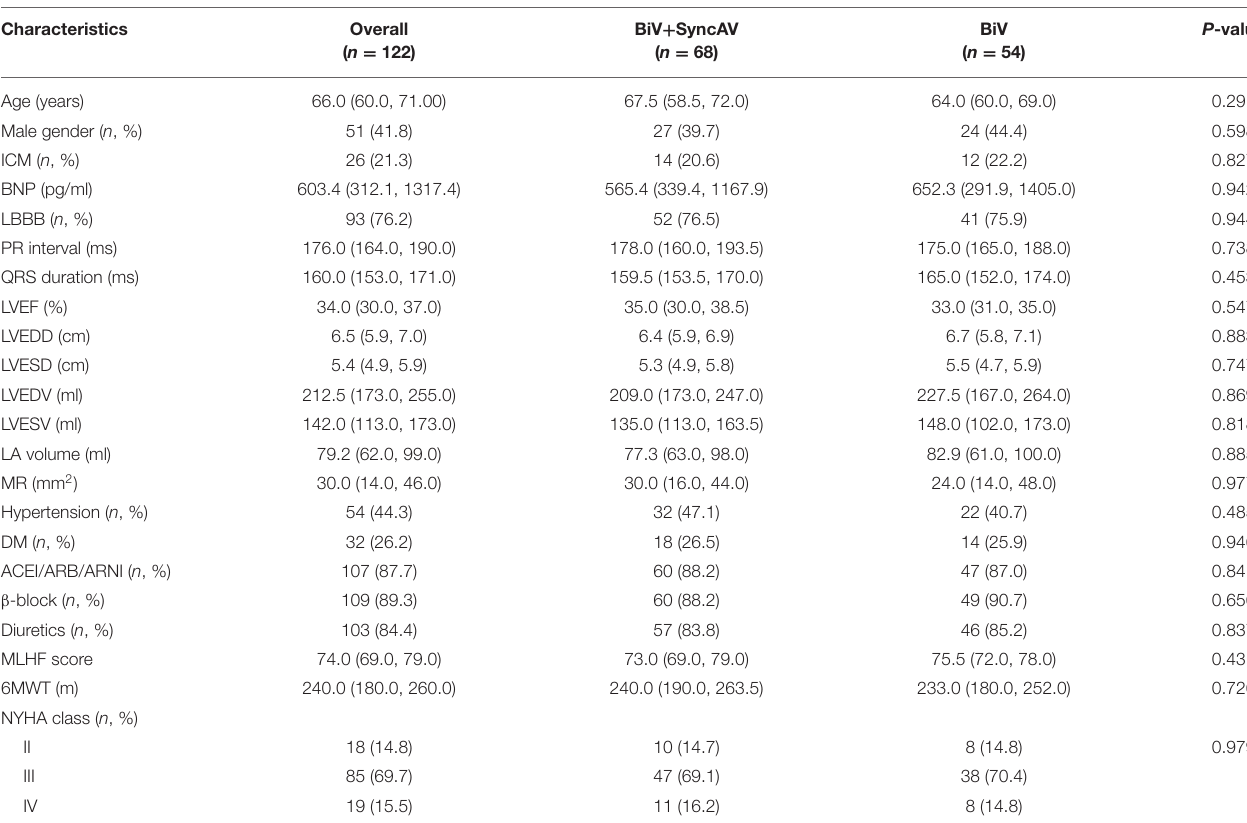
TABLE 1 | Baseline characteristics of study population.